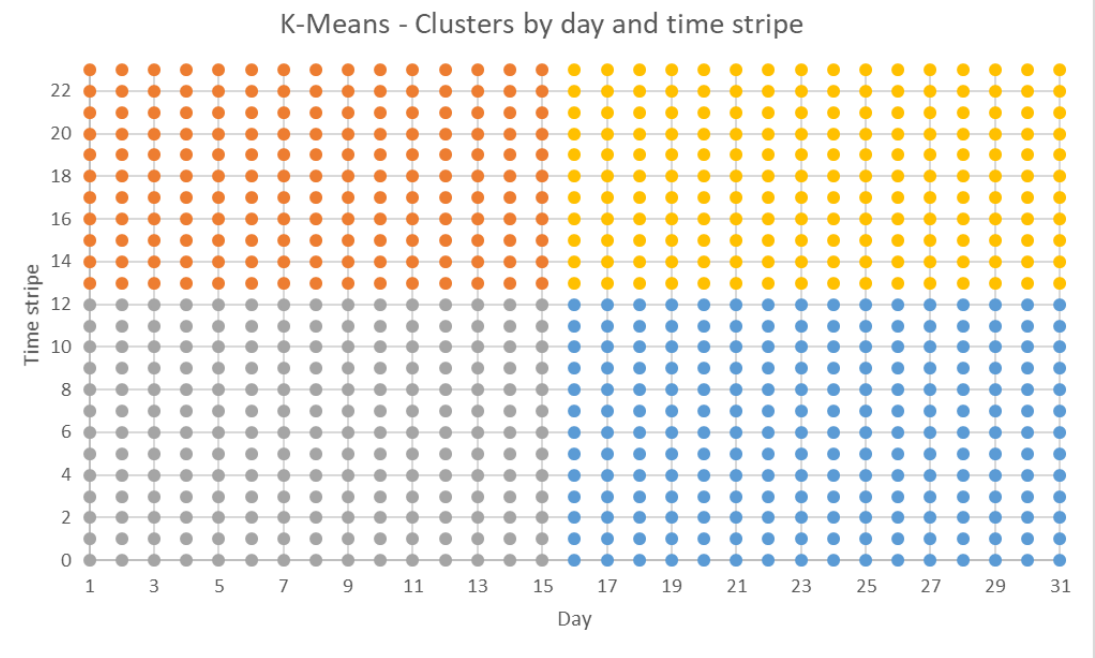
Figure 5. Source: Author’s elaboration.